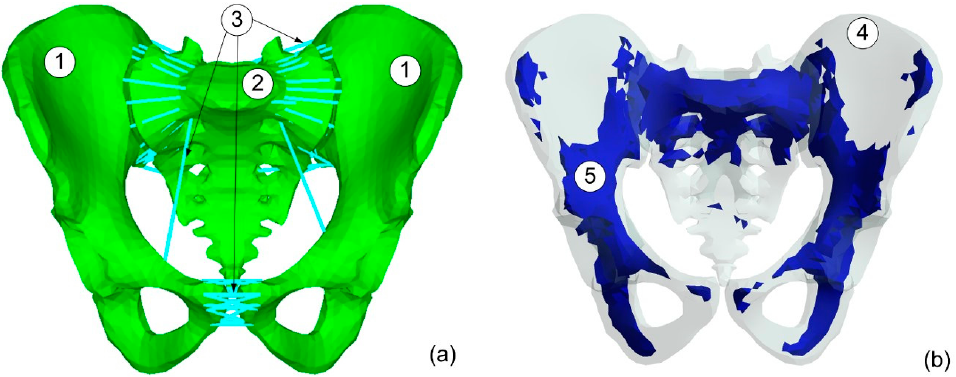
Figure 1. Model of pelvic ring with ligaments. ( a ) Pelvis model: 1—Pelvic bones, 2—Sacrum, 3—Ligaments, ( b ) Trabecular bone map: 4—cortical bone, 5—trabecular bone.